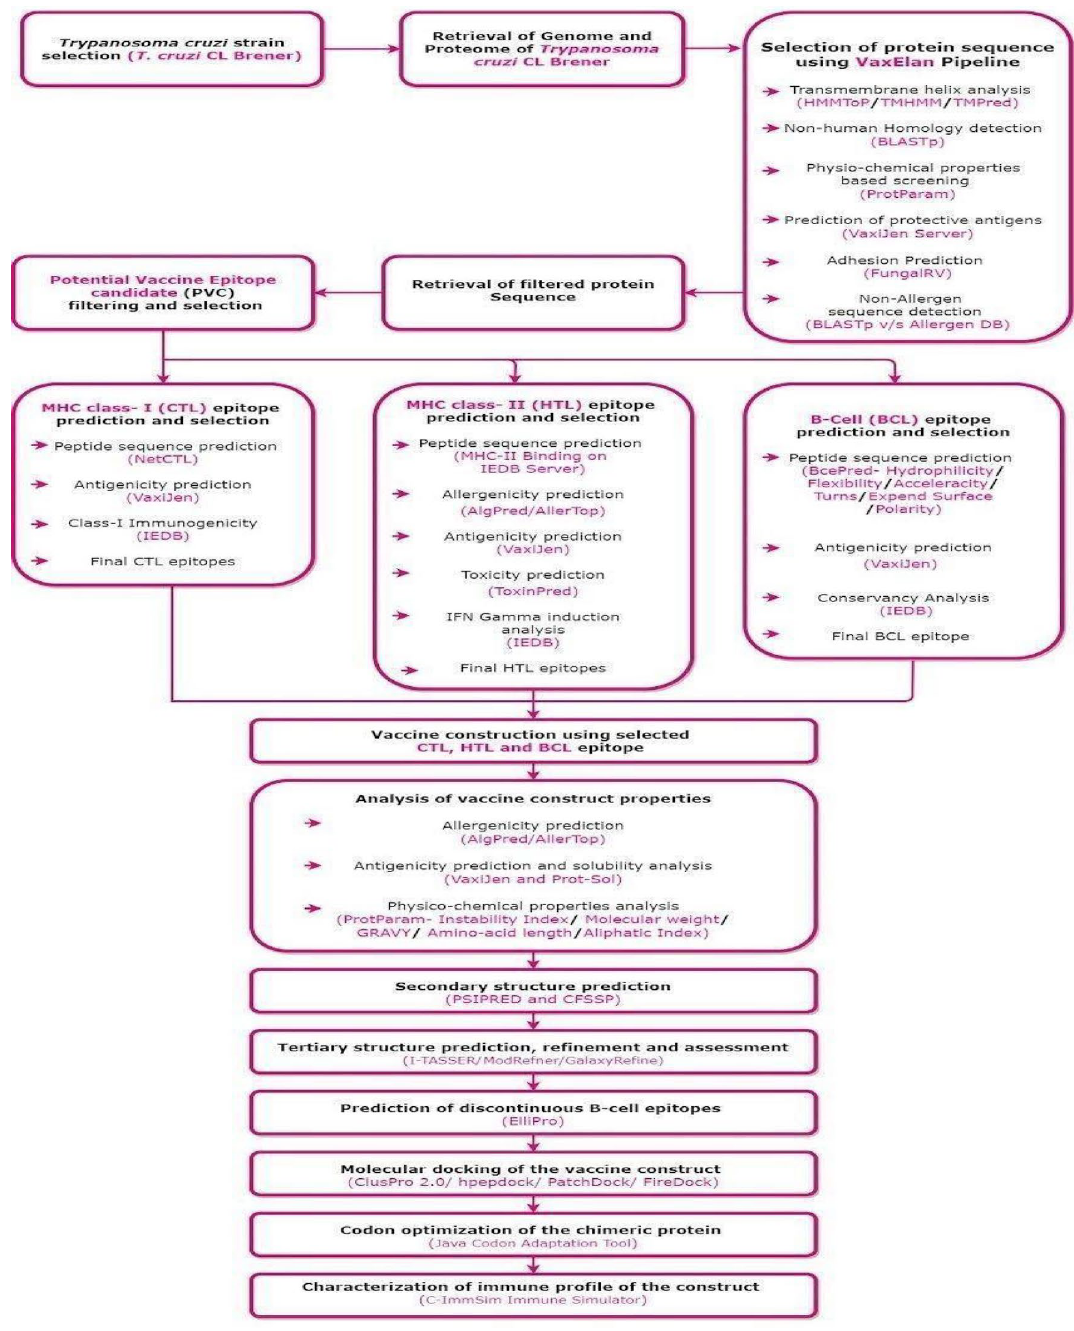
Figure 1. Methodology for developing a multi-epitope subunit vaccine construct (Draw.io—https:// www. diagr ams. net/- 14.6.